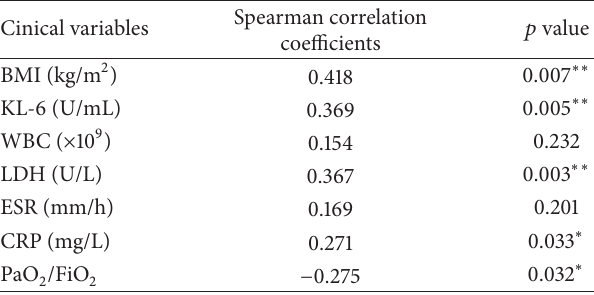
Table 2: Bivariate correlation analysis between plasma leptin levels and clinical variables among 62 patients with IPF. Cinical